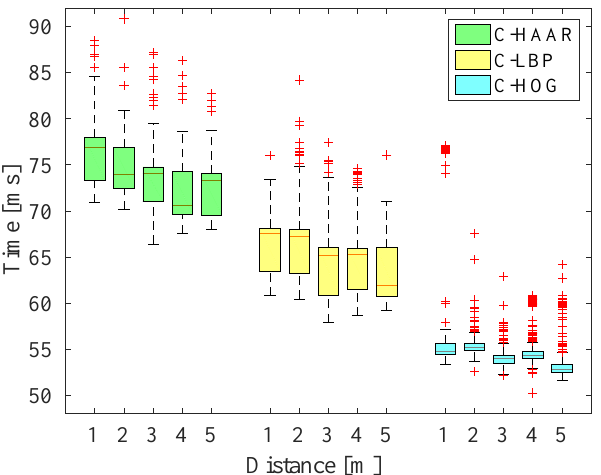
Figure 19. Change of computation time required to process one video frame with respect to the distance of the